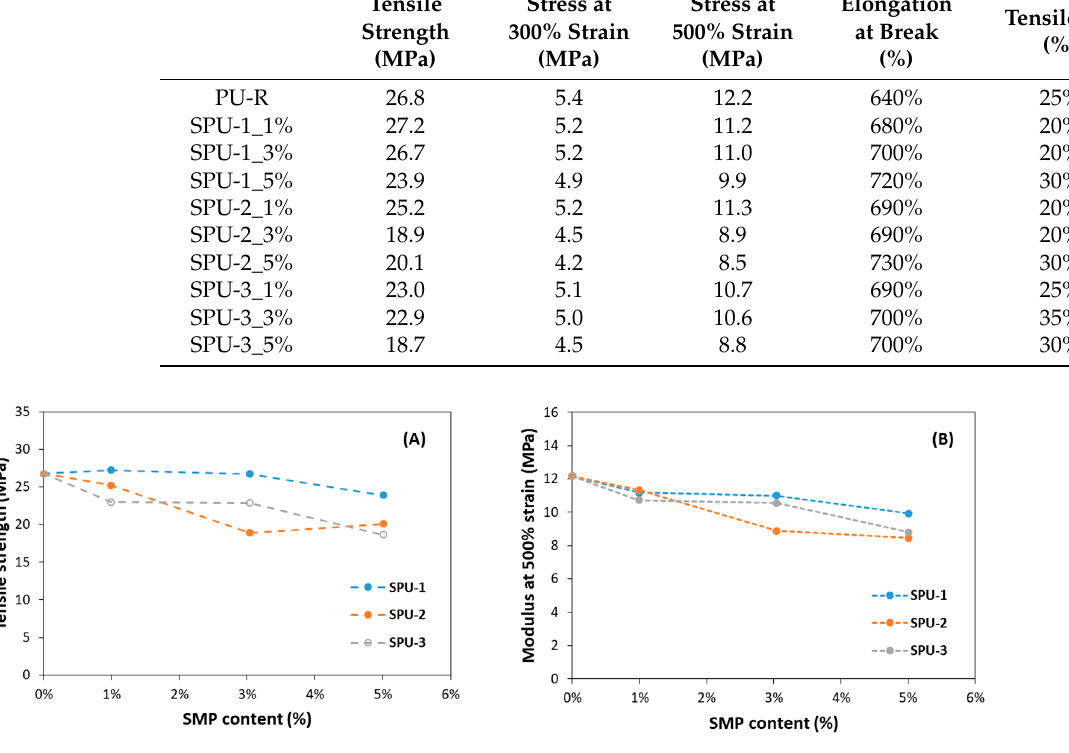
Figure 4. Plots of tensile strength ( A ) and modulus ( B ), as indicated by stress at 500% strain of SPU coatings against the SMP contents.